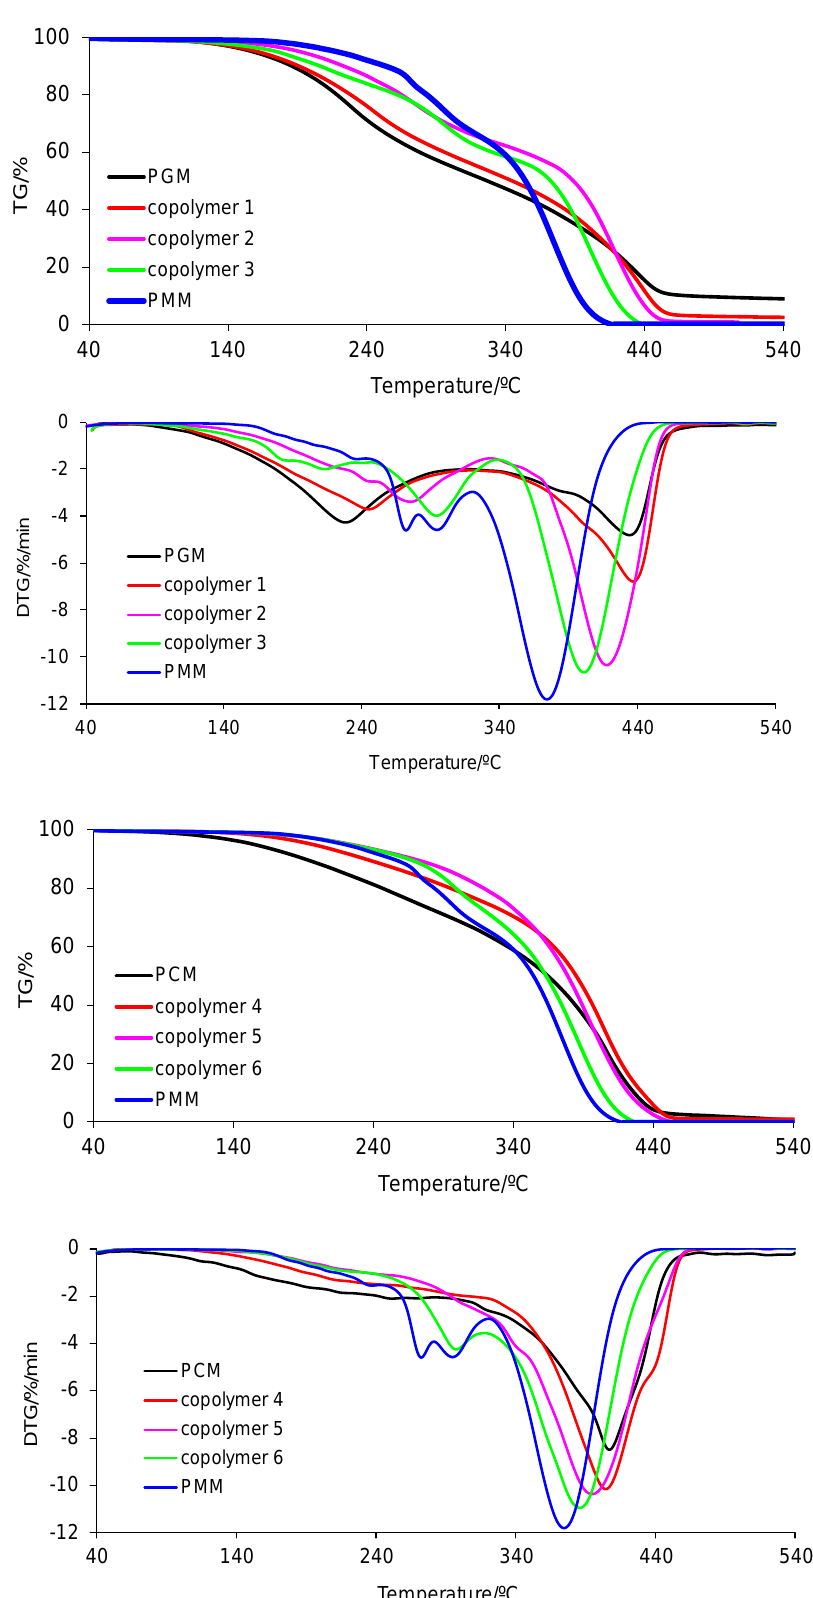
Figure 4. TG/DTG curves for polymeric materials obtained in helium (samples conditioned at 50 ◦ C—series